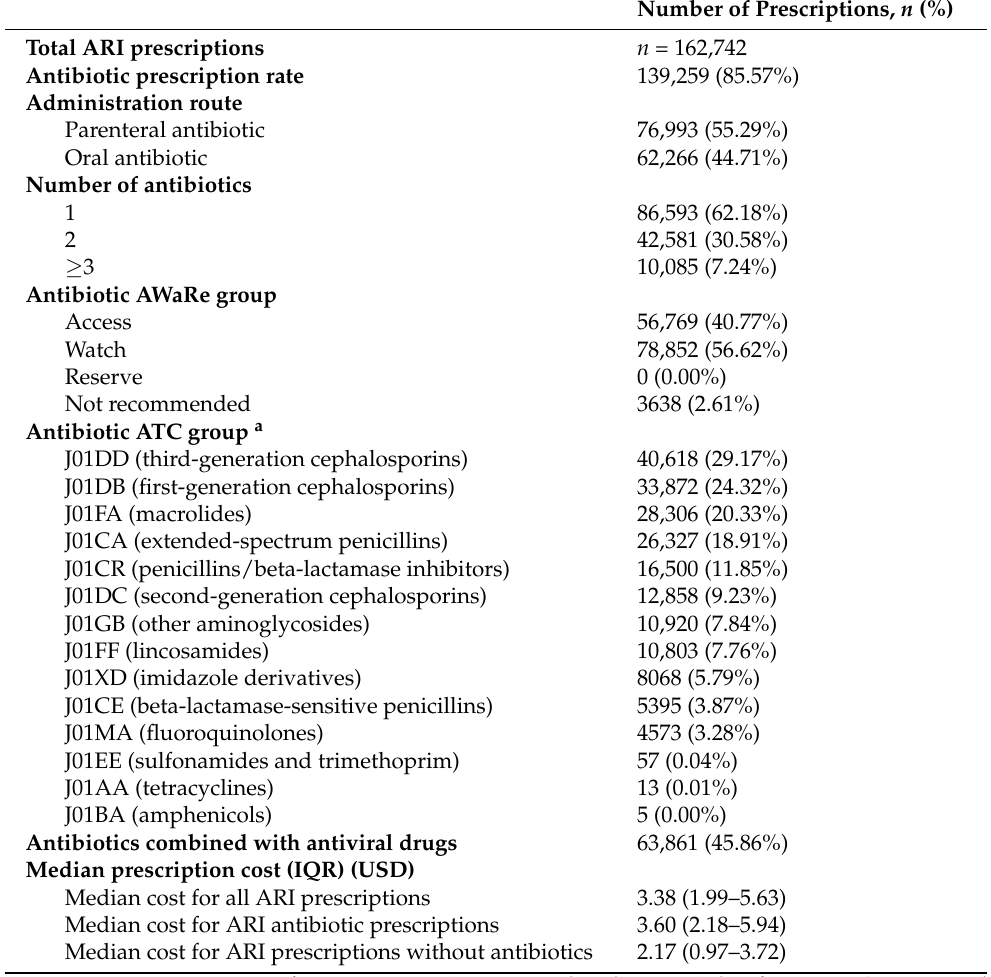
Table 2. Overall antibiotic prescription patterns for patients with ARIs in the eligible prescription